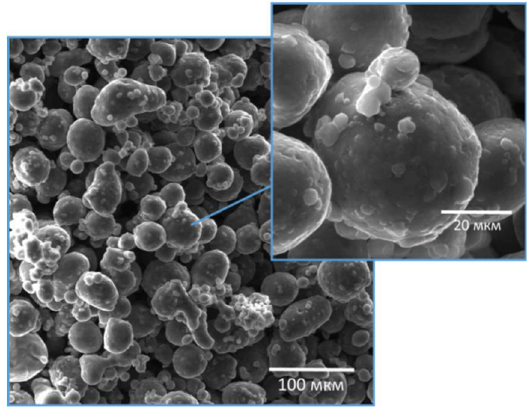
Figure 1. Scanning electron mycroscopy images of Al–Si10–Mg powder. Table 1. Chemical composition of Al–Si10–Mg powder. Element